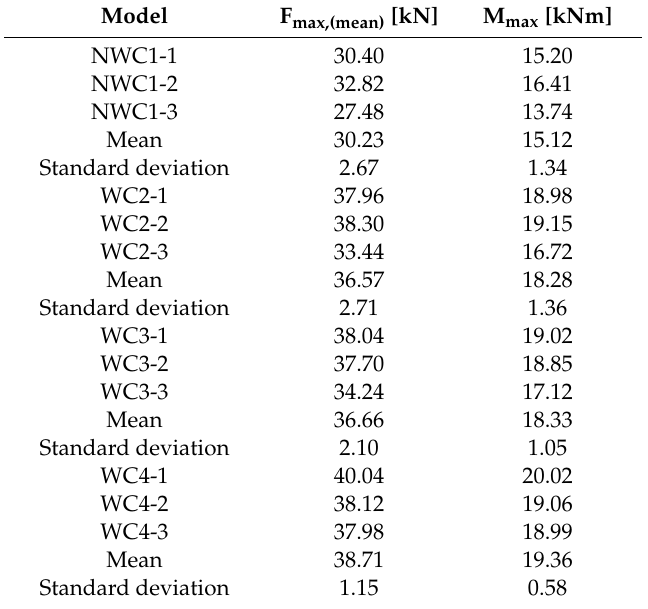
Table 1. Magnitude of the destructive force and corresponding bending moment for each